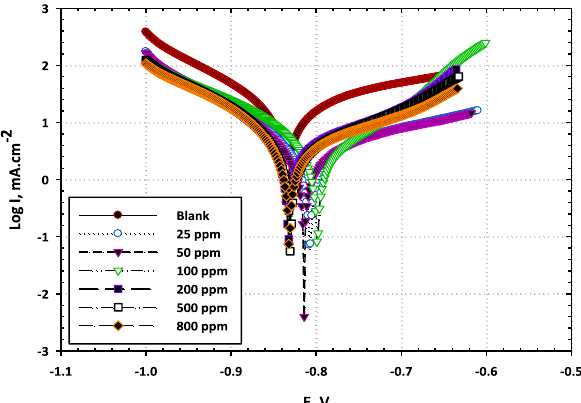
Figure 1. Potentiodynamic polarization curves for the carbon steel in a 3.5% NaCl medium with and without different concentrations of